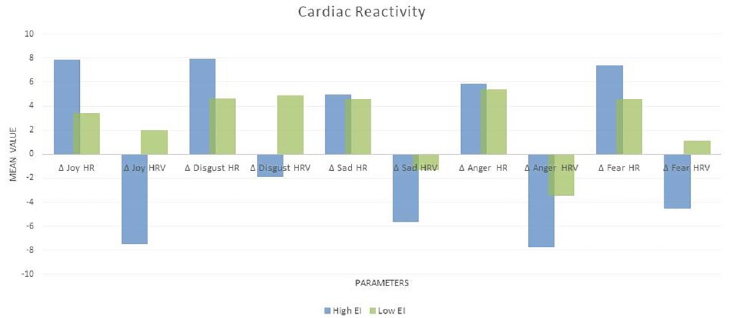
Fig 5. Mean cardiac reactivity of high and low EI